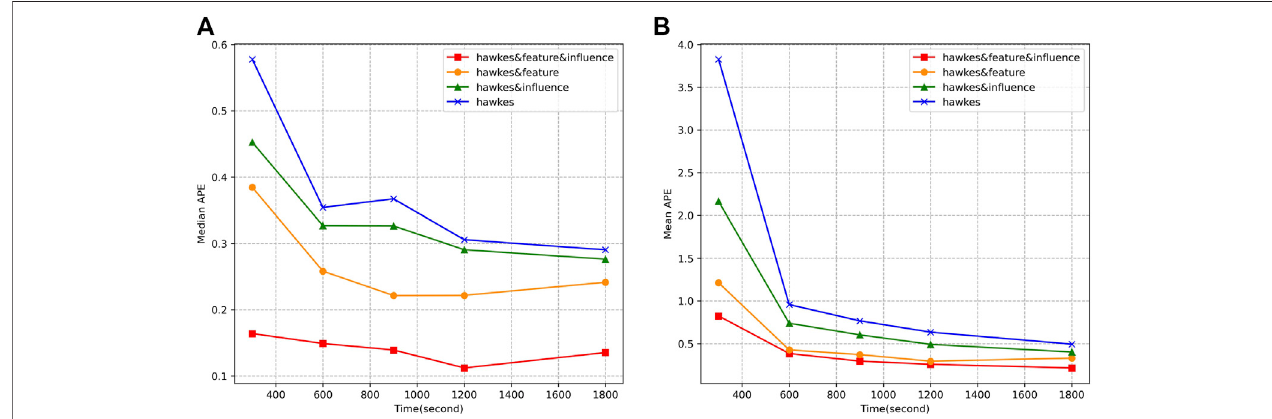
FIGURE 6 | Comparison of APE of different models on dataset 2. (A) Evolutionary trend of the median APE with prediction time t , (B) Evolutionary trend of mean APE with prediction time t .